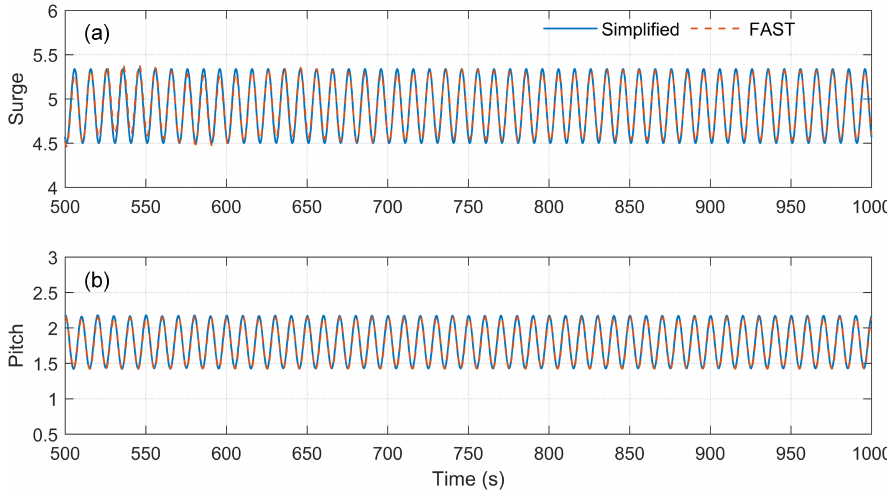
Figure 9. Time response of motion RAO for semi-submersible floater under regular wave: ( a ) Surge; ( b ) Pitch.